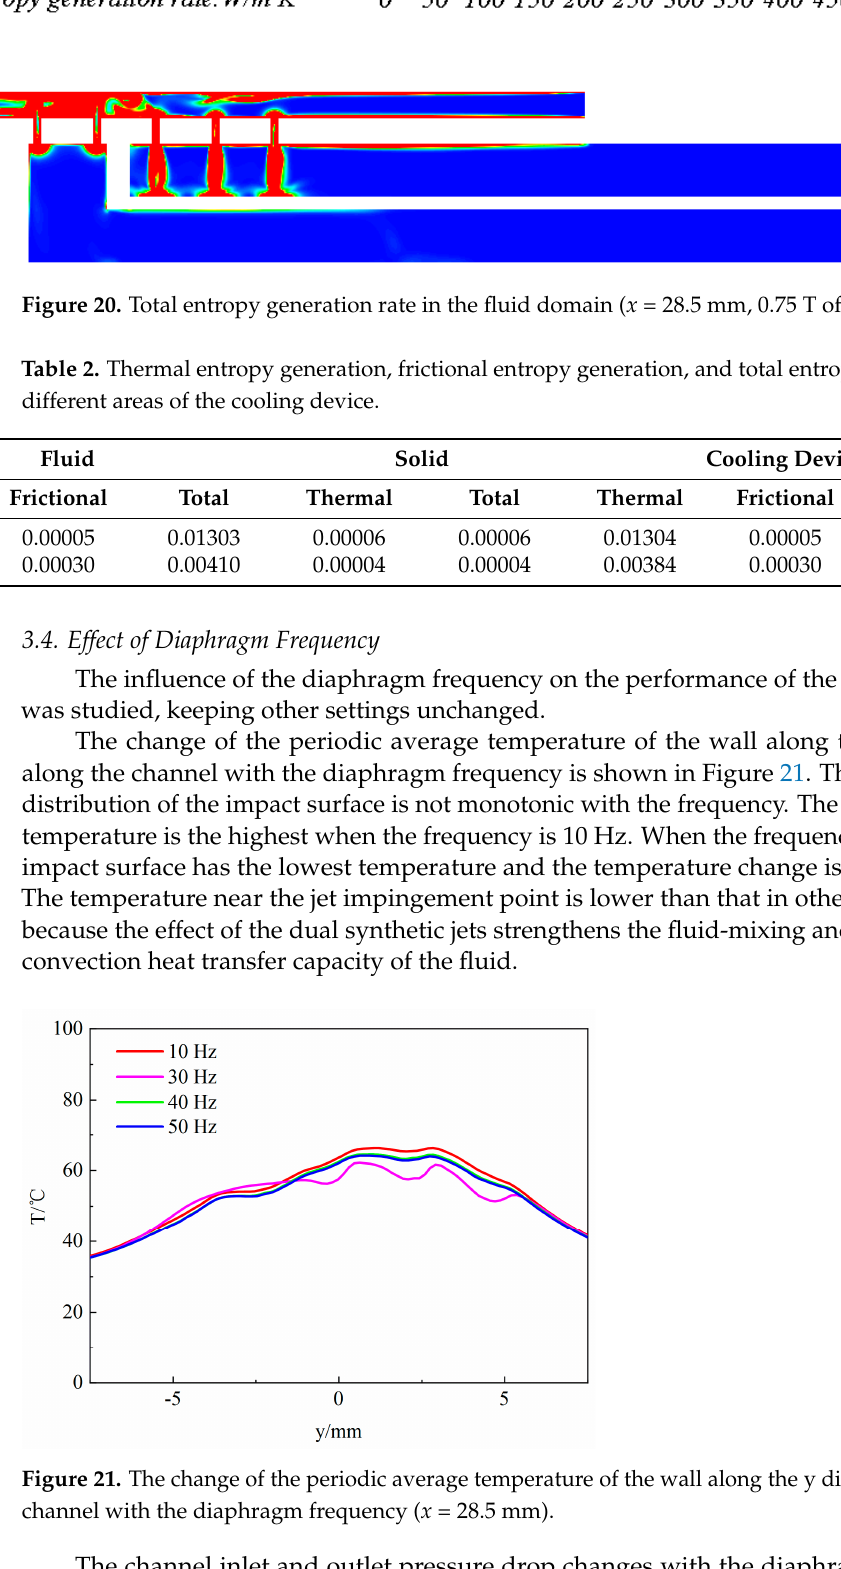
Figure 22. The channel inlet and outlet pressure drop changes with the diaphragm frequency ( x = 28.5 mm). 4. Conclusions In this paper, combined with the DSJ technology, a forward liquid cooling device is designed. The heat transfer and flow characteristics of the device are analyzed. The en- tropy generation of the DSJA is analyzed from the point of view of the second law of thermodynamics. The main conclusions are as follows 